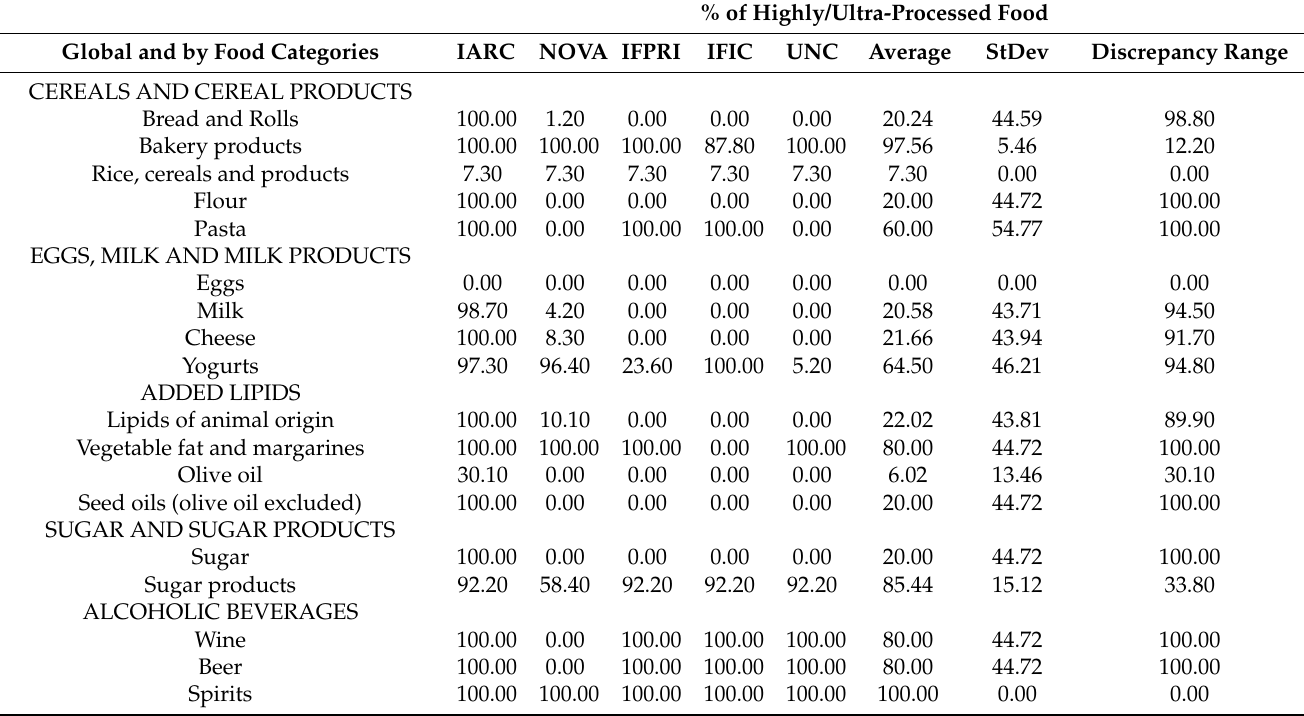
Table 4. Contribution of highly/ultra-processed food and beverages according to different